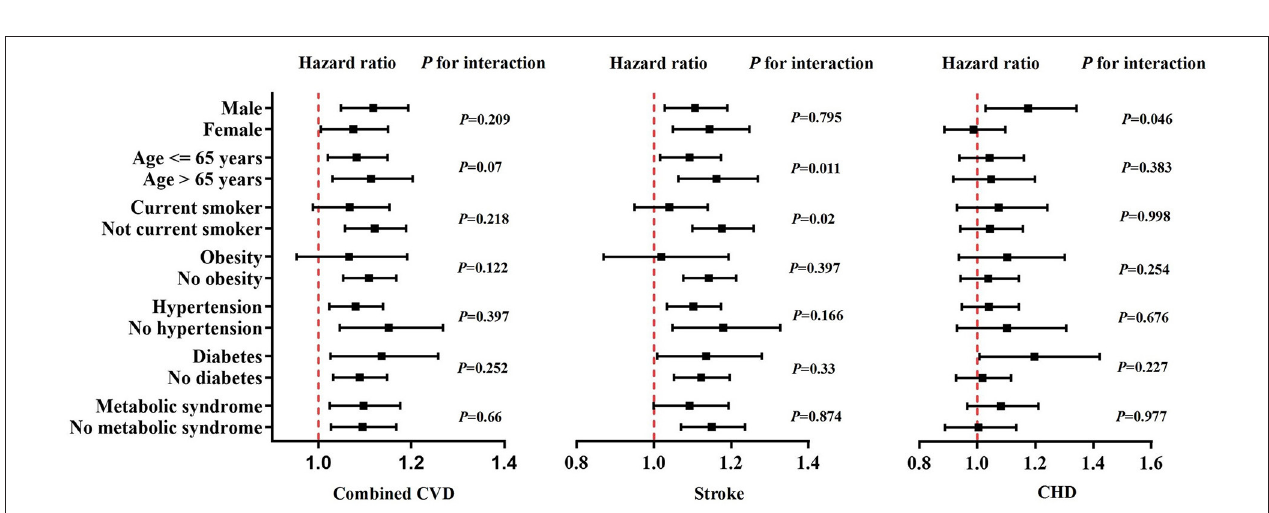
FIGURE 3 | Multivariate-adjusted hazard ratios for cardiovascular events associated with each 10ms increase of QTc interval within subgroups of the study participants. Black squares in the graph represent the hazard ratio and lines represent the 95% confidence interval. The vertical red line indicates a hazard ratio of 1. Adjustment factors are as Model 4 in Table 2 . CHD, coronary heart disease; CVD, cardiovascular disease.